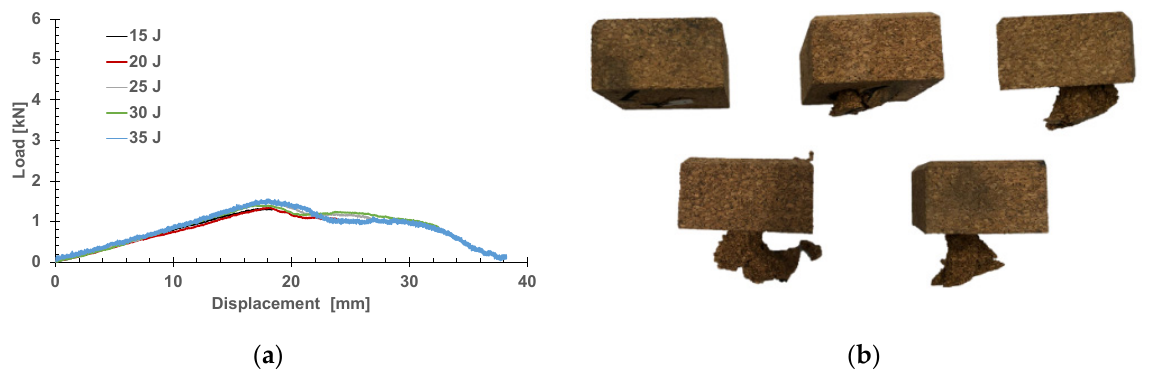
Figure 4. Load-displacement curves ( a ) and damaged PUF panels ( b ) with thickness t ≈ 25 mm.